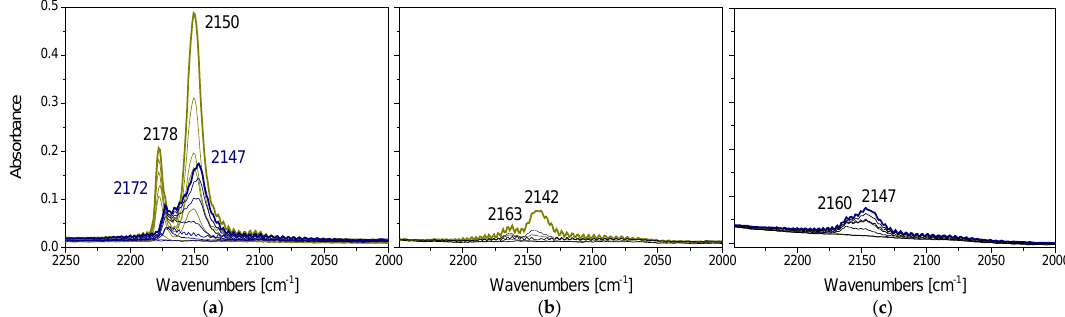
Figure 8. ( a ) Comparison among the FTIR spectra collected upon 5 mbar CO adsorption and at decreasing CO pressures at − 170 ◦ C on I1.0Cu / P25 (dark yellow curves) and D1.0Cu / P25 (blue curves); ( b ) spectra of adsorbed CO and decreasing CO pressures at − 170 ◦ C collected on I1.0Cu / P25 after ethanol adsorption (dark yellow curve) and further outgassing at r.t. (black curves); ( c ) spectra of adsorbed CO and decreasing CO pressures at − 170 ◦ C collected on D1.0Cu / P25 after ethanol adsorption (blue curve) and further outgassing at r.t. (black curves).